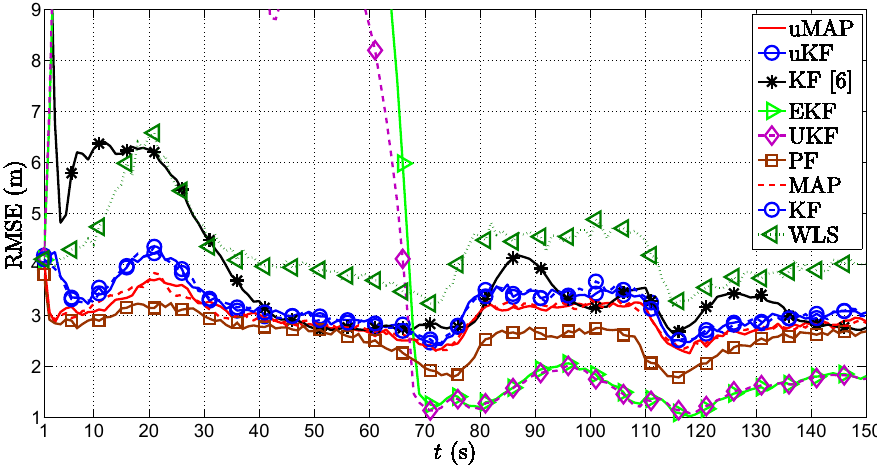
Figure 5. RMSE (m) versus t (s) comparison in the second scenario, when N = 3, (cid:107) v a (cid:107) = 0 m/s, = 9 dB, σ m = 4 π σ n rad, γ = 3, γ i ∼ U [ 2.7,3.3 ] , P 0 = − 10 dBm, q = 2.5 × 10 − 3 m 2 /s 3 , M c = 1000. 180 i i